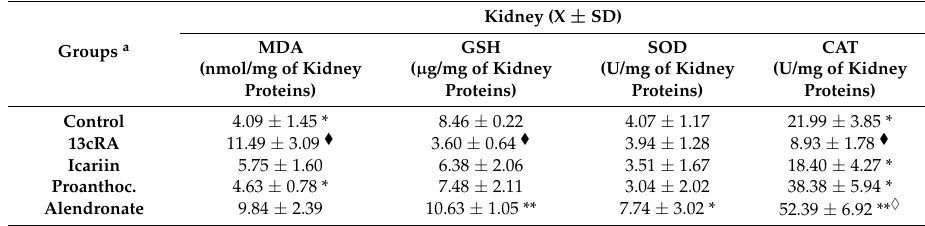
Table 6. Effect of icariin, proanthocyanidins and alendronate on kidney malondialdehyde (MDA) and glutathione (GSH) level and superoxide dismutase (SOD), and catalase (CAT) activities in rats with retinoic acid-induced bone loss.